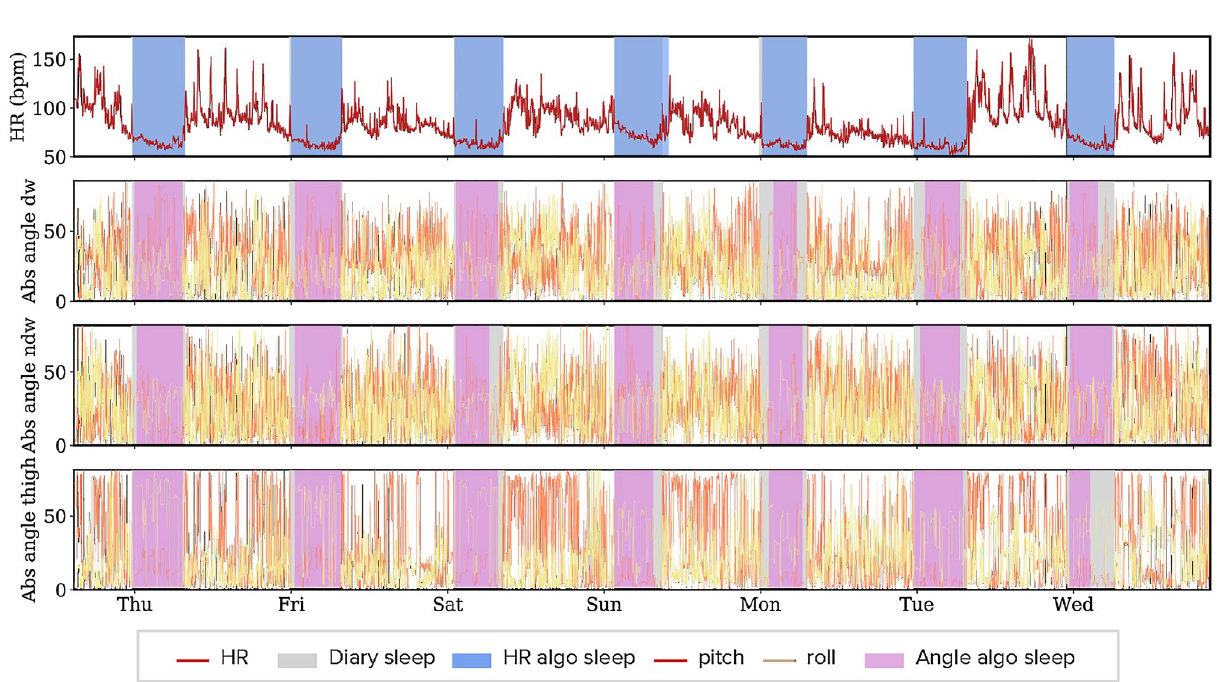
Figure 5. Example participant (chosen at random), showcasing estimated sleep through the heart rate sleep window algorithm, sleep diary sleep onset and offset and angle changes for both wrists and the thigh accelerometers. The algorithm picks up subtle sleep regularity differences at a participant level. This approach overlaps more closely to the sleep diary than any of the accelerometer-based approaches. Notice that, for the angle change approach, the algorithm is more effective on the non-dominant wrist accelerometer than on the dominant wrist or thigh accelerometer for most nights. TST: total sleep labels by -55.04 and -34.04 minutes, respectively for the HR algorithm and sleep diaries, a difference that was statistically significant. Interestingly, our algorithm was better at inferring sleep offset (-15 minutes compared to PSG labels, versus about -30 minutes for sleep diaries), but worse at detecting sleep onset (40 minutes, versus 6 minutes for the sleep diary). As the MESA study only recorded night-time data, the HR quantile optimal for the 24-hour BBVS data was not suitable. Instead, we benchmarked the MESA data against the best HR quantile for a night-only window of the BBVS cohort, which was 0.80. This led to an MSE of 0.11 between the HR algorithm and PSG sleep labels.